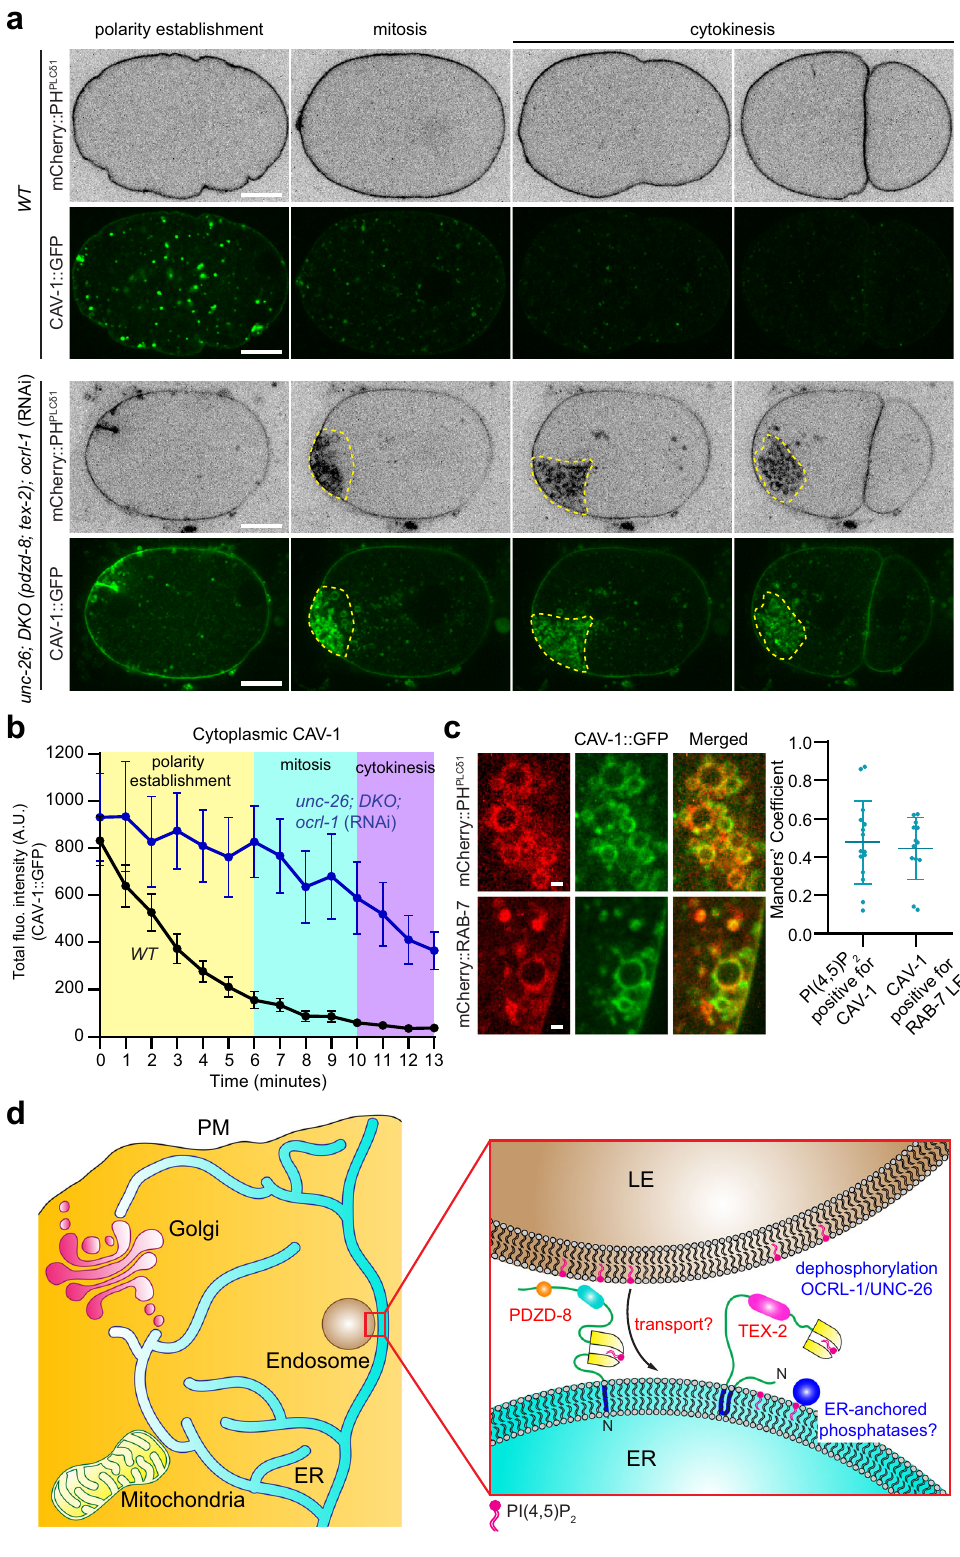
degradation of CAV-1::GFP was markedly delayed, and unde- graded CAV-1::GFP signals were clearly present in the cytoplasm even after completion of cytokinesis (Fig. 8a, b and Supplemen- tary Movie 11). Strikingly, these cytoplasmic CAV-1::GFP signals extensively overlapped with PI(4,5)P 2 -positive vesicles (marked by mCherry::PH PLC δ 1 ) and late endosomes (marked